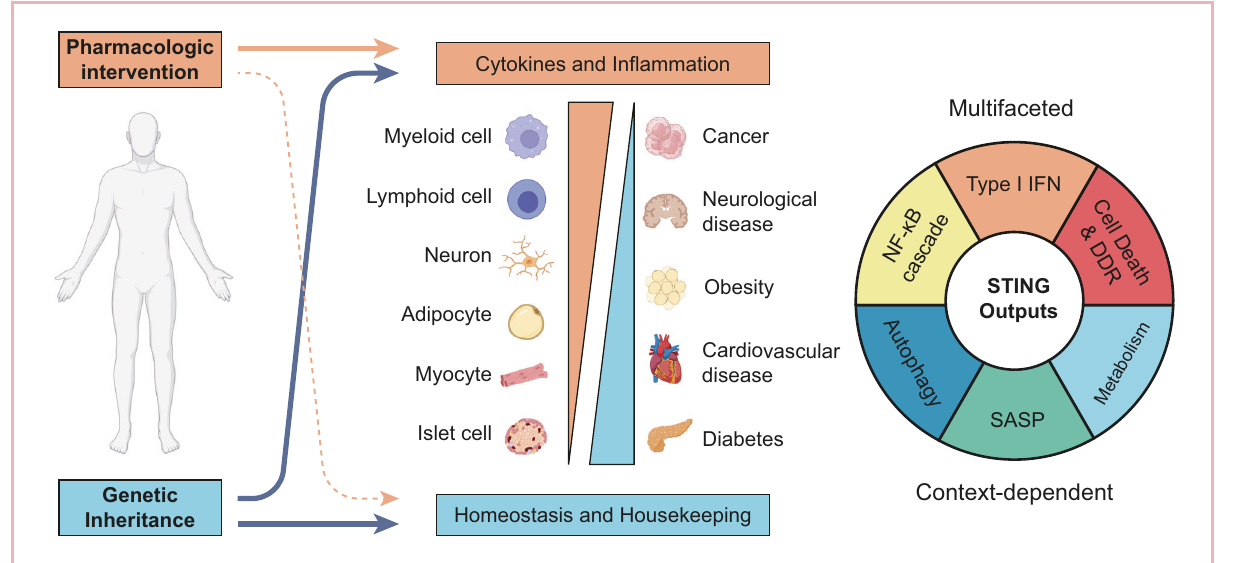
Fig. 7 STING involvement in different diseases from a reductionist perspective. STING presents multifaceted outputs in highly differentiated cells. In immune cells like the myeloid line and lymphoid line, STING activation mainly results in cytokine secretion and in fl ammation induction, while in cells like pancreatic islet cells or myocytes, STING may act as a housekeeping protein to maintain the homeostatic function of cells. In this regard, STING depletion in such cells may impair physiological function. Current pharmacological intervention towards STING mainly targets its cytokine-inducing function and is aimed at in fl ammation-dominant diseases, such as cancers and auto-immune diseases. However, the genetic knockout of STING in animal models may comprehensively turn off all its outputs, including those in both immune cells and structural cells. Thus, the control of STING in different diseases may yield the opposite outcome or zero-sum phenotypes, depending on the composing proportion of the multifaceted roles of STING. DDR DNA damage response, SASP senescence-associated secretory phenotype. Created with